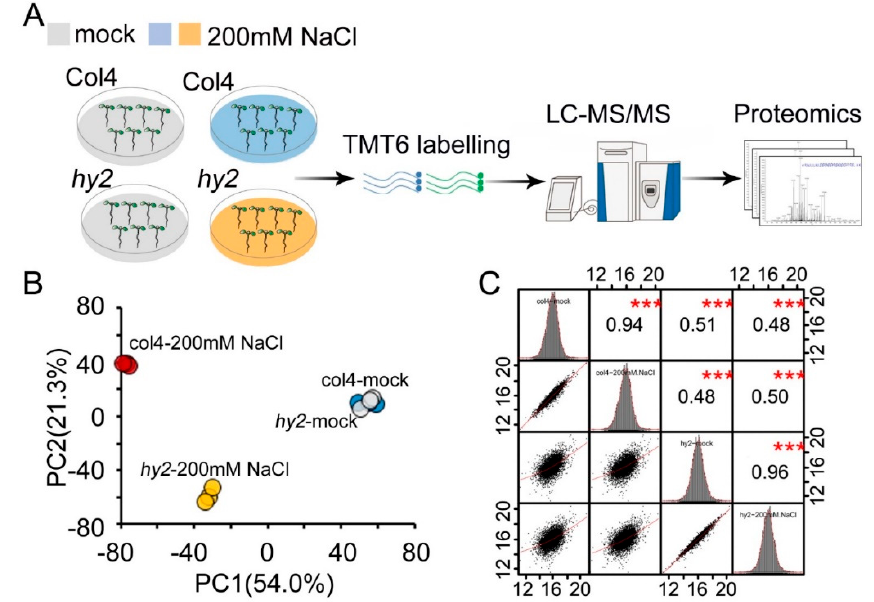
Figure 2. Quantitative proteomics analysis of col4 and hy2 mutant under salt stress. ( A ) Workflow of proteomics analysis. Five-day-old col4 and hy2 mutant seedlings were treated with or without 200 mM NaCl for 5 h. The proteomics analysis consists of three steps. Step 1, proteins were extracted from tissues and proteolytically digested. Step 2, TMT6 labelling. Step 3, nano-HPLC-MS/MS. ( B ) Unsupervised principal component analysis (PCA) of quantitative proteomics data. ( C ) Scatterplot matrices by which linear and nonlinear relations were investigated. The value represents the Pearson correlation between treatments. The red asterisk showed in ( C ) represents a significant difference between treatments: *** p < 0.001.